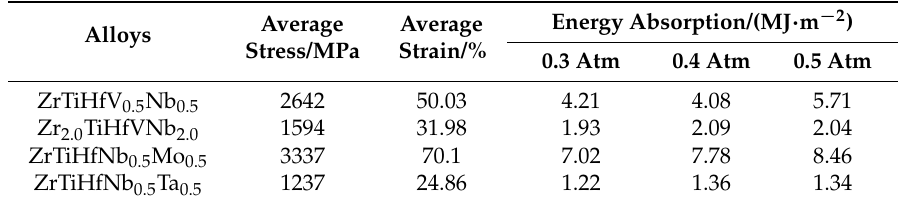
Table 4. The dynamic compressive mechanical properties and energy absorption of the RHEAs. Alloys